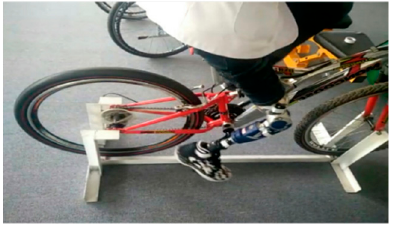
Figure 3. Bicycle riding of prosthetic wearers.